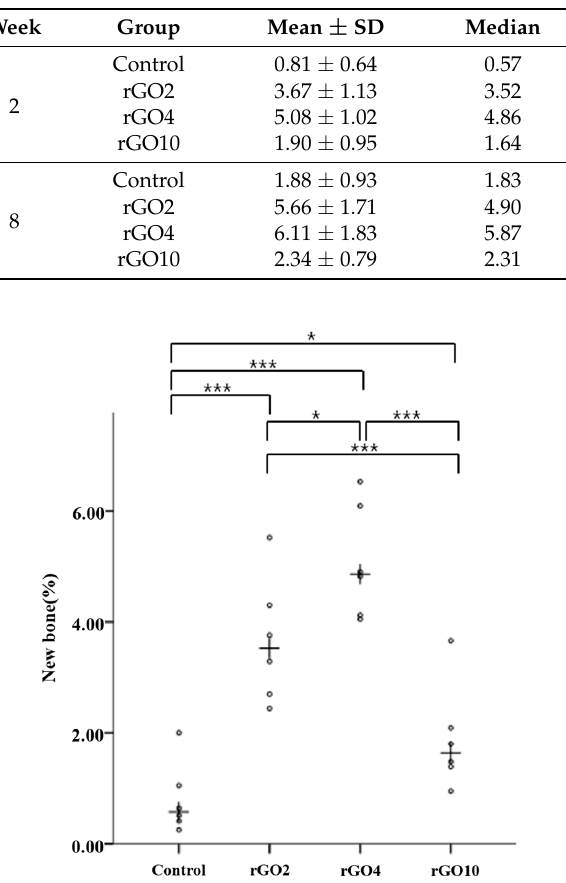
Figure 9. Scatter plot and medians (crosses) of new bone area percentages (%) at 2 weeks after surgery (* p < 0.05, *** p < 0.001).